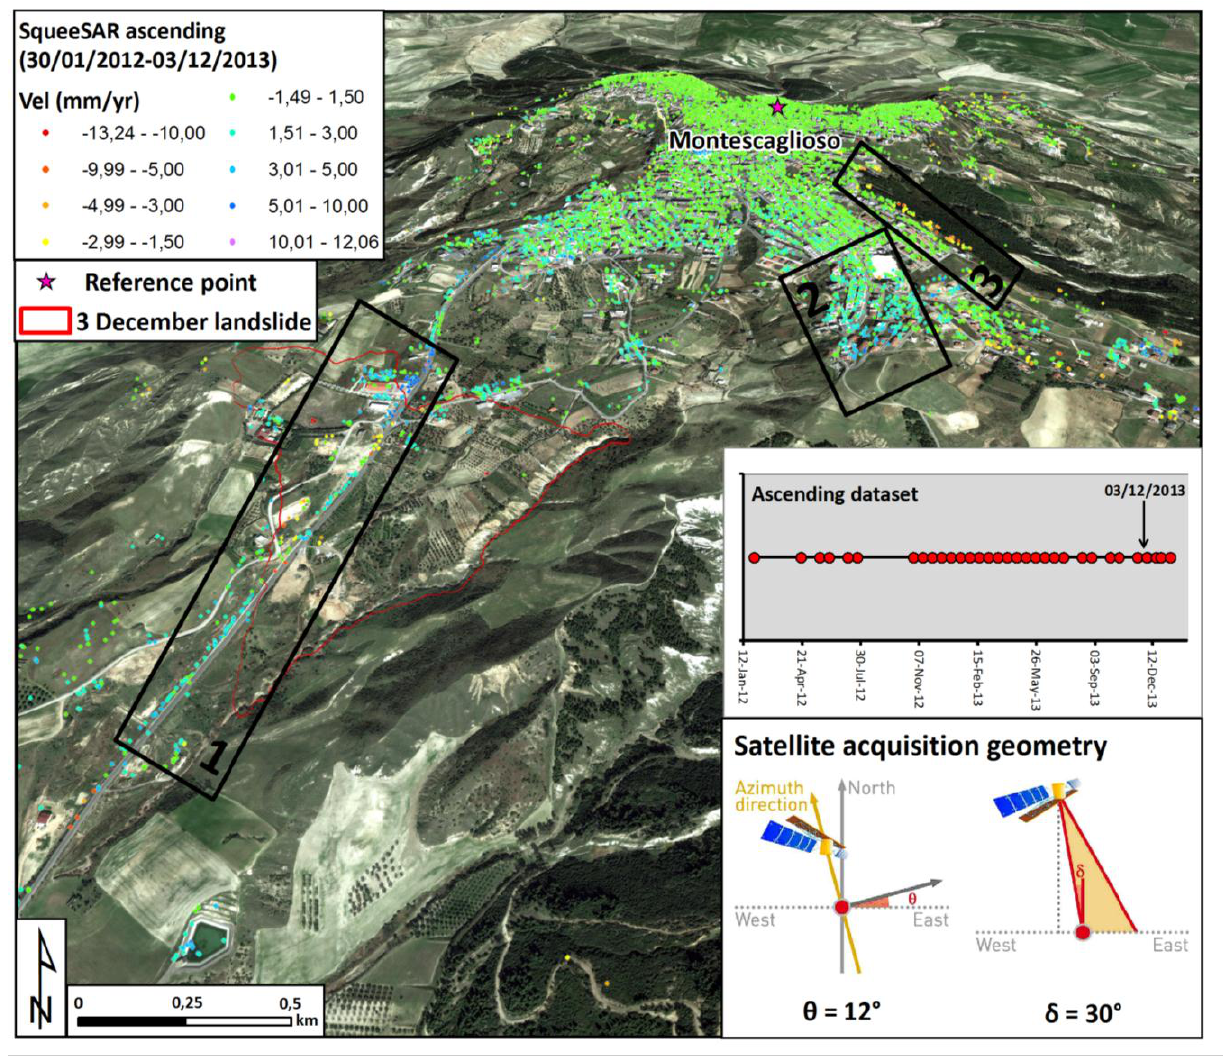
Figure 4. Pre-event SqueeSAR results (ascending geometry) for the area of Montescaglioso. SqueeSAR analysis provides also, for each measurement point, a time series of deformation, which describes the evolution of displacement over the entire period. Each measurement of the time series corresponds to a single satellite acquisition. A time series shows the temporal pattern of the deformation, highlighting non-linear movements, seasonal trends, ground acceleration and any potential changes occurring during the analyzed period. Four measurement points have been selected and corresponding deformation time series are presented in Figure 5. Points are located in the most critical areas, i.e. , the areas characterized by the highest deformation velocities, and have been selected to identify the presence of potential precursor movements and to evaluate changes in deformation rates. Points 1 and 2 correspond to the roofs of the supermarket and the artisan warehouse of Figure 1, respectively. As remarked before, both of these buildings have been severely affected by the 3 December landslide. Point 3 and point 4 are located along the Piani Bradano road, and straddle the landslide boundary. Analysis of deformation time series highlights, for all of them, an almost linear deformation trend. Beside a few minor oscillations, no significant accelerations before the 3 December event can be